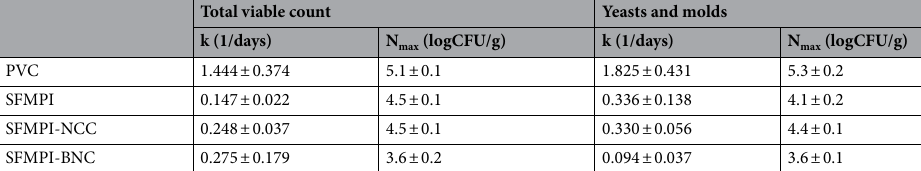
Table 3. Growth rates (k in 1/days) and final population (N max in logCFU/g) of total viable count and yeasts and molds in strawberries stored at 10 °C using conventional PVC and SFMPI-, SFMPI-NCC and SFMPI- BNC-based biofilms (Mean values ± standard error based on the statistical variation in the kinetic parameters of the Baranyi growth model-regression